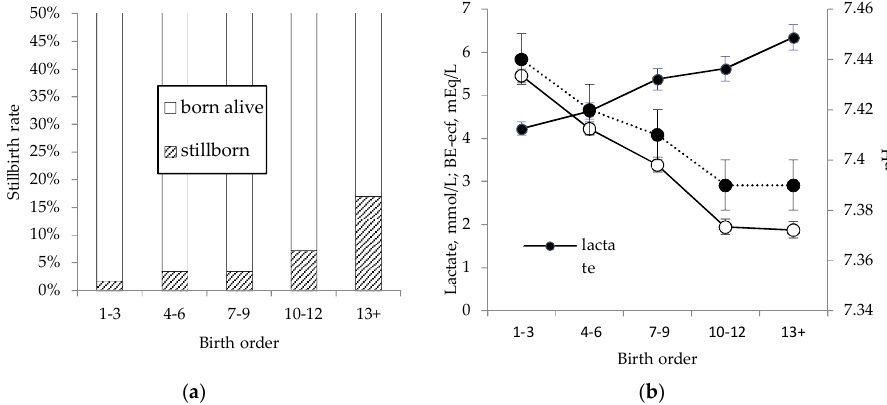
Figure 1. Stillbirth rate ( a ) and blood acid-base values ( b ) in relation to birth order. Data on stillbirth were obtained from 37 litters, and data for blood acid base values from 516 piglets. Mixed umbilical cord blood samples were obtained immediately at birth and analysed within 5 min. BE-ecf: base excess in extra-cellular fluid.